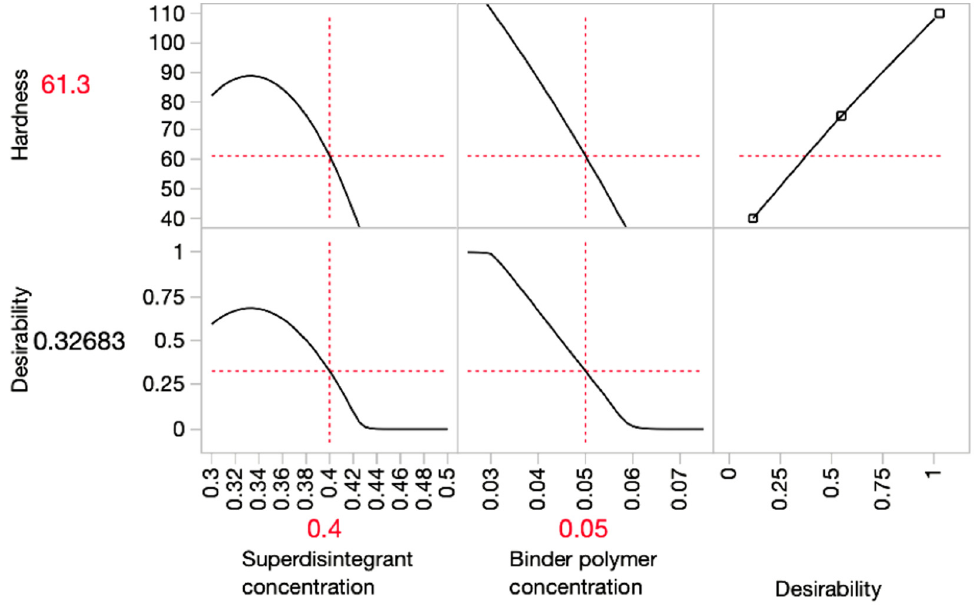
Figure 4. Prediction profiler graph for predicting the optimal formulation for achieving proper hard- ness. Table 9. Differences in preparation and fabrication via SSE of F2a, F2b and